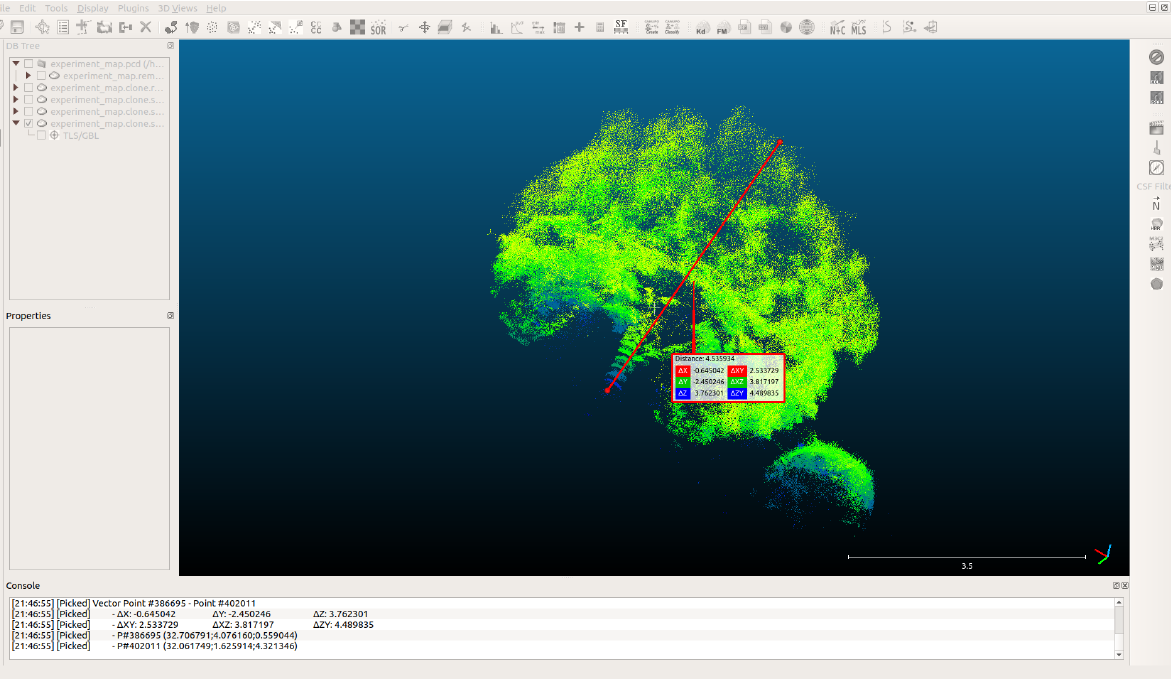
Figure 15. The example detection height of tree 8 height is 4.535m